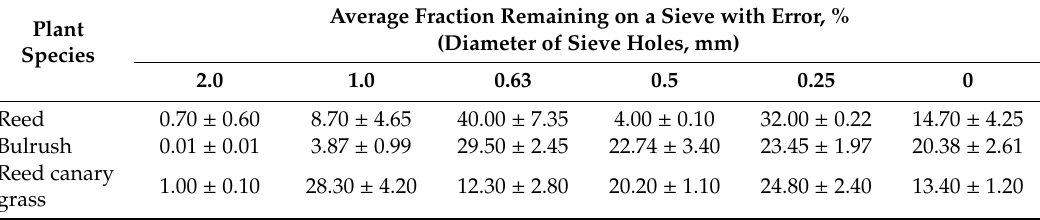
Table 1. Fractional composition of reed plant mills.